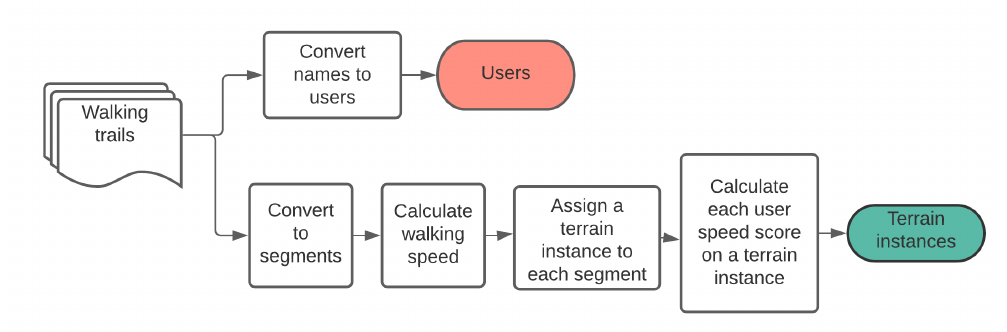
Figure 2: Pre-processing walking trails to obtain speed score for each user on visited terrain